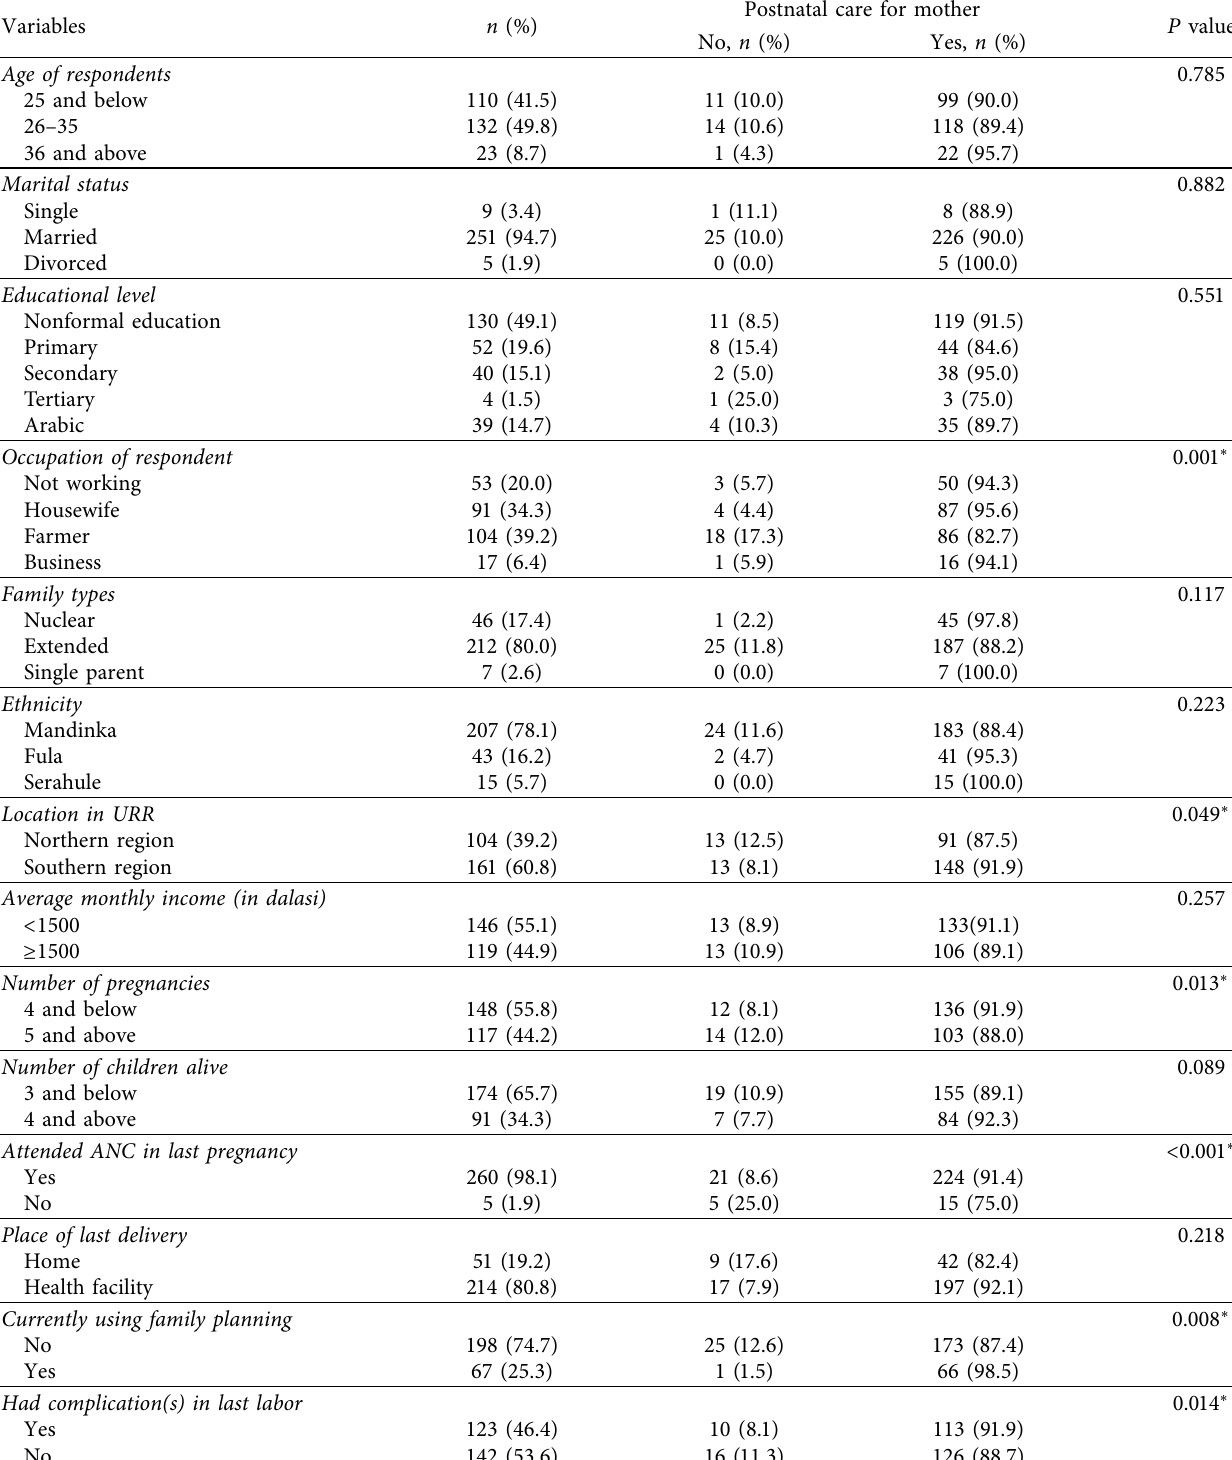
Table 1: Sociodemographic and related characteristics of reproductive age women in URR,